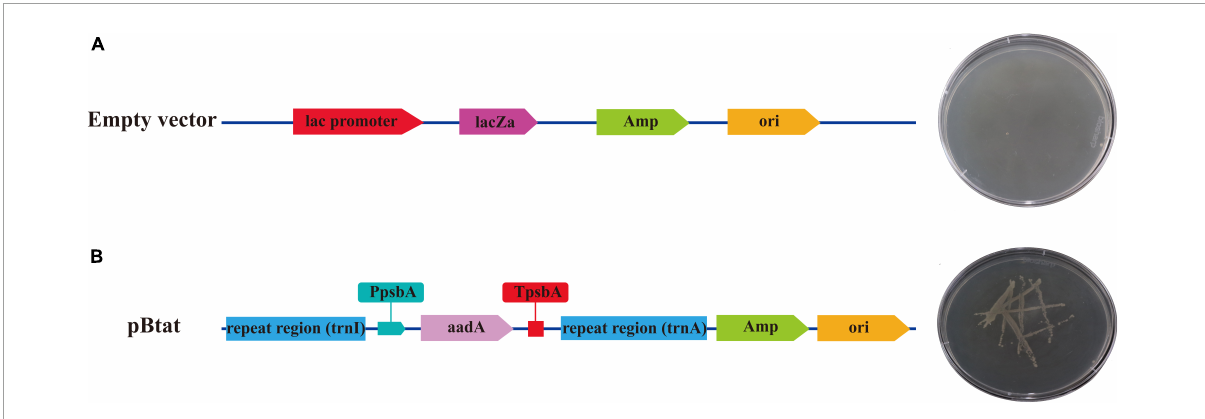
FIGURE9 The expression of aadA in Escherichia coli. (A) Escherichia coli containing empty vector. (B) Escherichia coli containing the recombinant